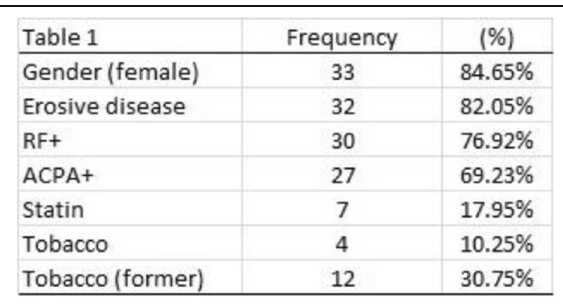
Table 1 (abstract P233). Demographic